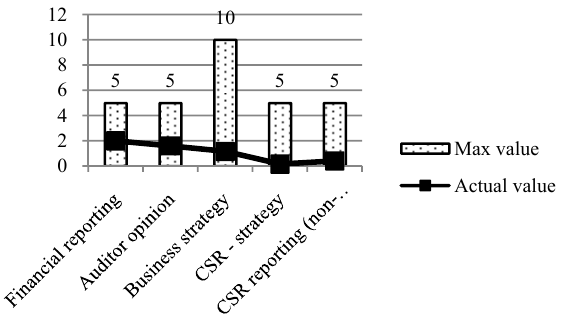
Fig. 1. The level of CSR disclosure on websites of companies on the parameter of “Strategy and Reporting” points, Center “CSR Development”